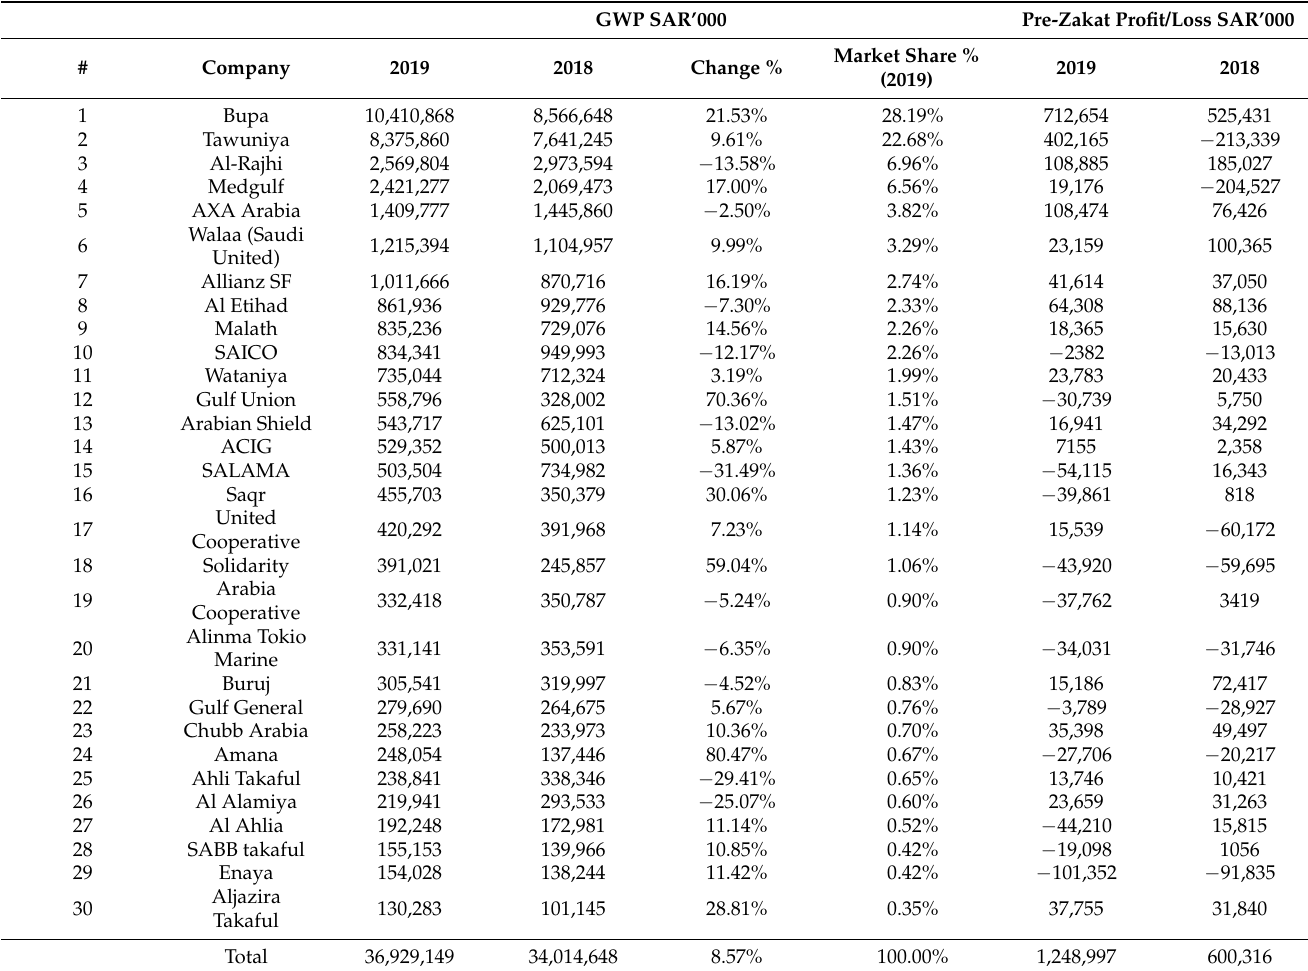
Table 3. Top 30 insurance companies’ financial performance. Source Noor (2020) and authors’